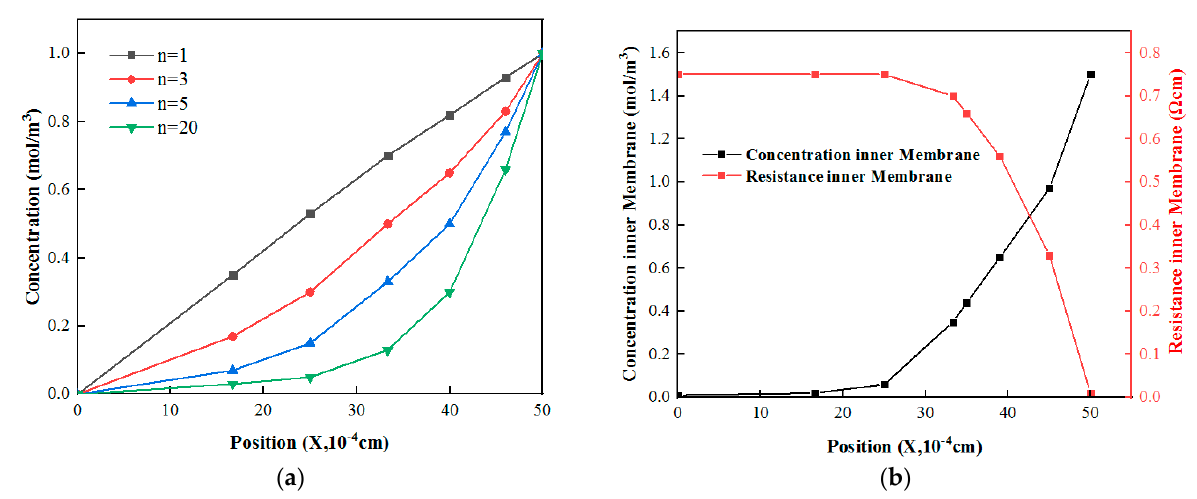
Figure 10. ( a ) Ion concentration changes at different positions in the membrane under different n